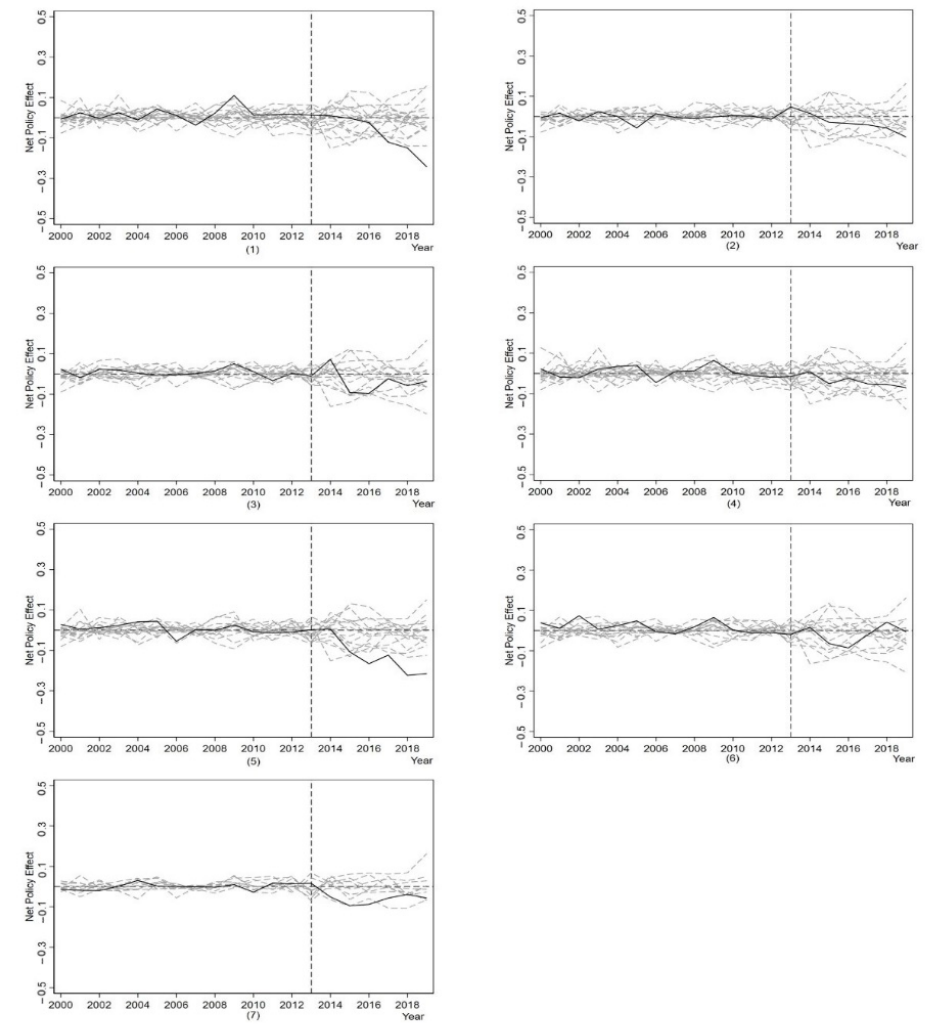
Figure 5. Placebo test result − 2. Note: (1)–(7) represent Beijing, Hebei, Anhui, Shanghai, Zhejiang, Jiangsu, and Guangdong.